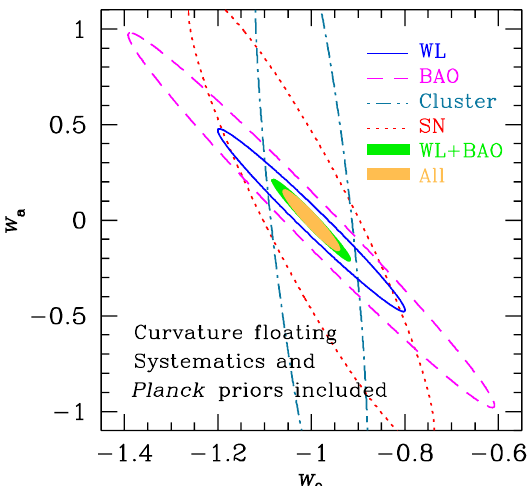
Figure 13. 1- σ Fisher forecast for w 0 and w a from future Large Synoptic Survey Telescope (LSST) Figure 15.3: Joint w 0 – w a constraints from LSST BAO (dashed line), cluster counting (dash-dotted line), supernovae Baryonic Acoustic Oscillations (BAO) (dashed line), cluster counting (dot-dashed line), supernovas (dotted line), WL (solid line), joint BAO and WL (green shaded area), and all combined (yellow shaded area). The Type Ia (SN, dotted line), Weak Lensing (WL, solid line), BAO + WL (green area) and all combined BAO and WL results are based on galaxy–galaxy, galaxy–shear, and shear–shear power spectra only. Adding other (yellow probes such as strong lensing time delay ( 12.4), ISW e↵ect ( 13.7), and higher-order galaxy and shear statistics § § ( 13.5 and 14.4) will further improve the constraints. § §